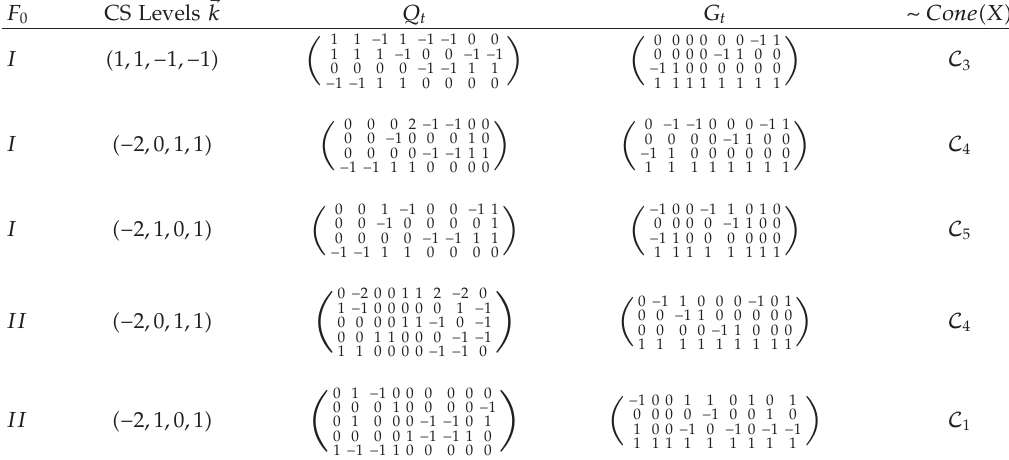
Table 3: The two phases of the (cid:4) 3 (cid:5) 1 (cid:6) -dimensional gauge theory for the cone over the zeroth Hirzebruch surface F 0 beget 4 new QCS theories in (cid:4) 2 (cid:5) 1 (cid:6) dimensions, the moduli spaces for which are cones over 4 di ff erent Fano